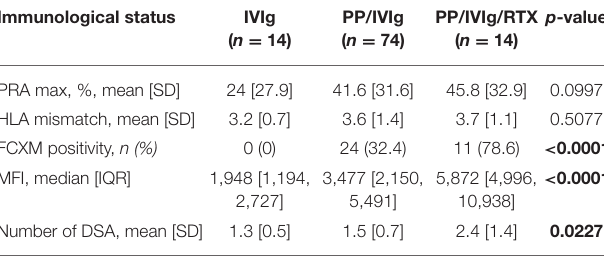
TABLE 3 | Pretransplant immunological characteristics of recipients receiving